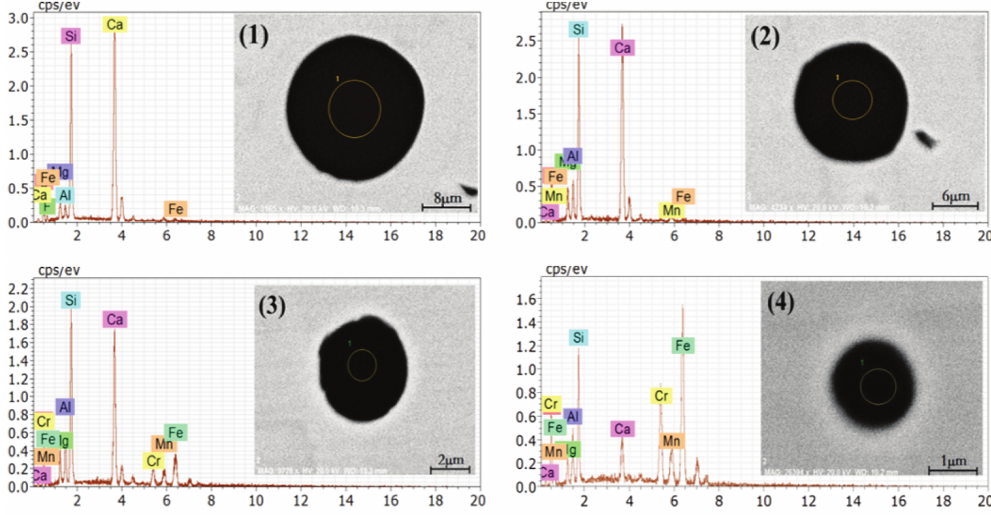
Figure 1: Morphologies and the EDS results of four typical inclusions.